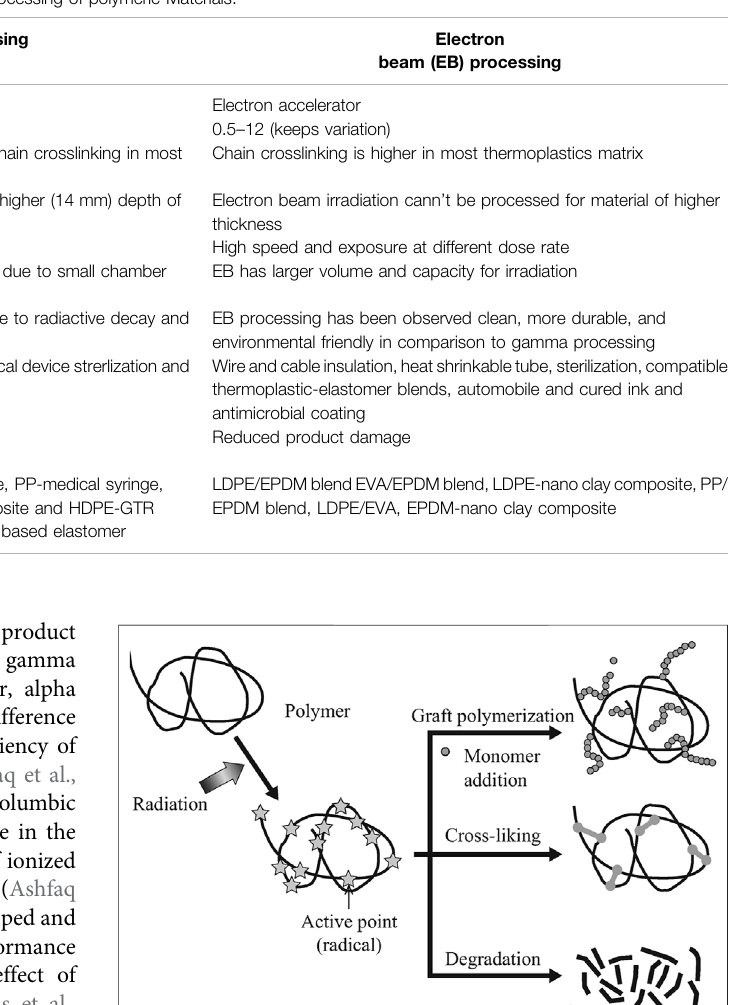
TABLE 3 | Difference between gamma and electron beam radiation processing of polymeric Materials.